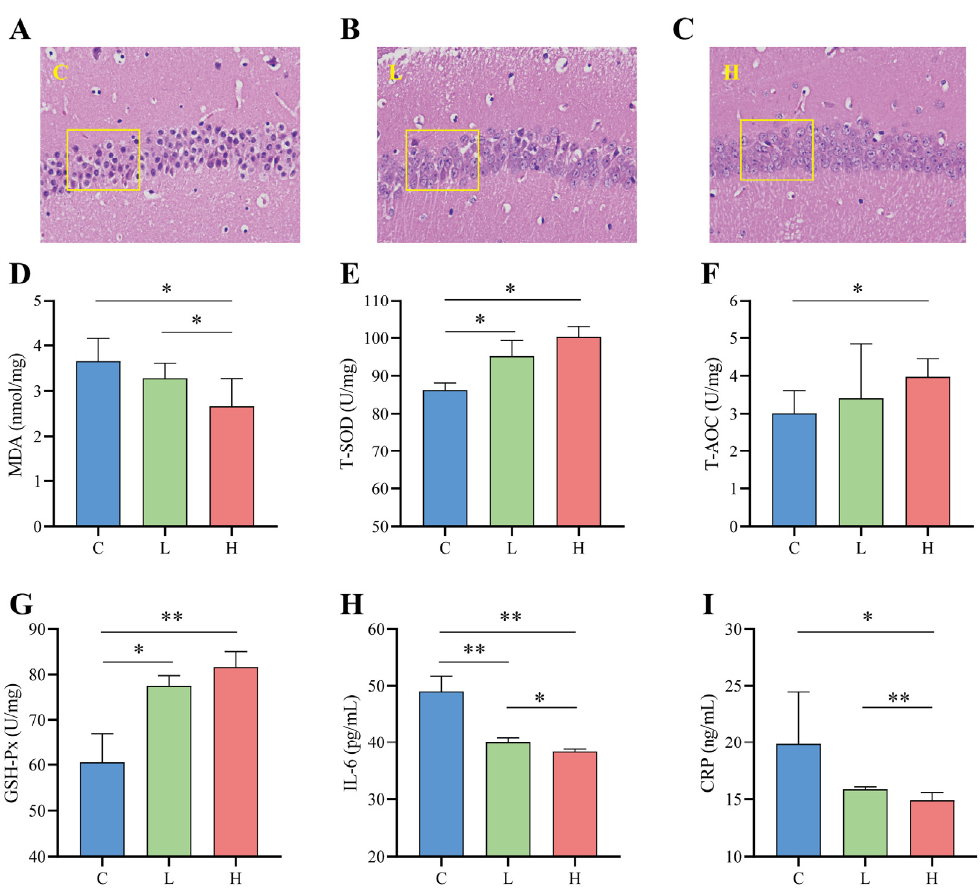
Figure 6. Effects of probiotic combinations on inflammation and oxidative stress in the brains of naturally aged mice. ( A – C ) Pathological sections (400×) of the CA1 region of the hippocampus of each group of mice, where ( A ) indicates control group C, ( B ) indicates low-dose intervention group L, and ( C ) indicates high-dose intervention group H. ( D – F ) Effect of the complex probiotics on antioxidant activity in the brains of naturally aged mice, showing the changes in MDA ( D ), T-SOD ( E ), T-AOC ( F ), and GSH-Px ( G ). ( H , I ) Changes in the effect of probiotic combinations on brain inflammation in naturally aged mice results show changes IL-6 ( H ) and CRP ( I ). * indicates p < 0.05; ** indicates p < 0.01.